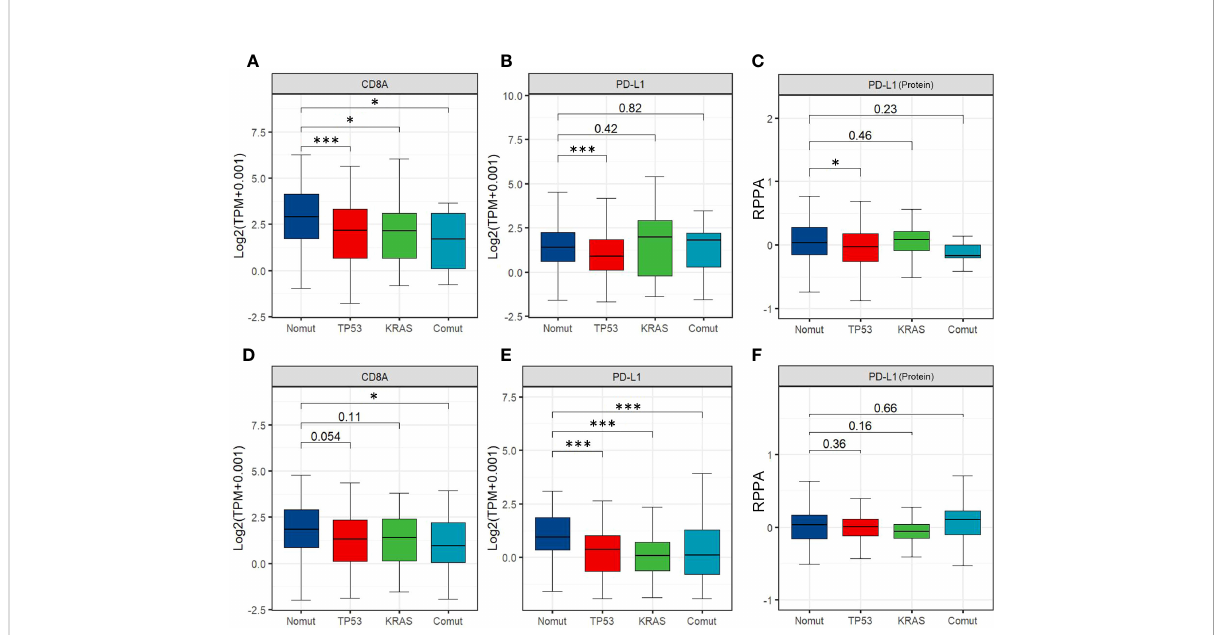
FIGURE 3 (A, B) Expression of CD8A and PD-L1 among STAD'sTP53/ KRAS mutation groups. (C) Expression of PD-L1 protein among different TP53/ KRAS mutation groups in STAD. (D, E) Expression of CD8A and PD-L1 among different TP53/ KRAS mutation groups in COAD. (F) Expression of PD-L1 protein among different TP53/ KRAS mutation groups in COAD. (Wilcox test. *, P<0.05; ***,